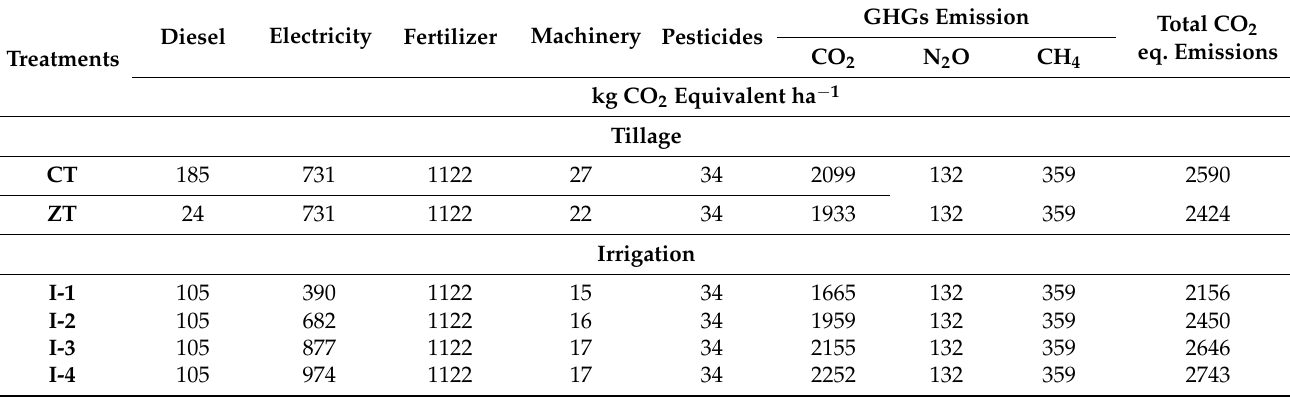
Table 8. Greenhouse gas (GHGs) emissions as influenced by different management